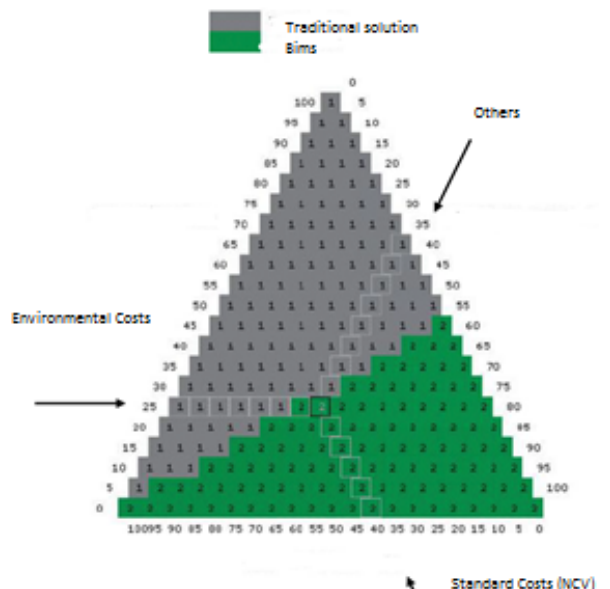
Figure 4. Output from BALANS, comparison of a traditional solu- tion and a Bims construction.